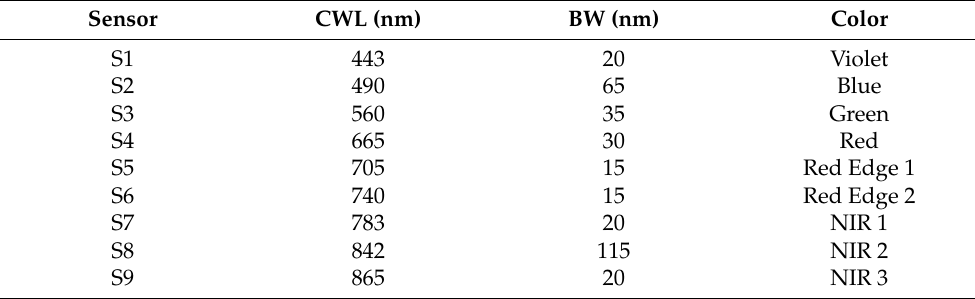
Table 1. Summary of optical bands detected by the MAIA multispectral camera sensors.